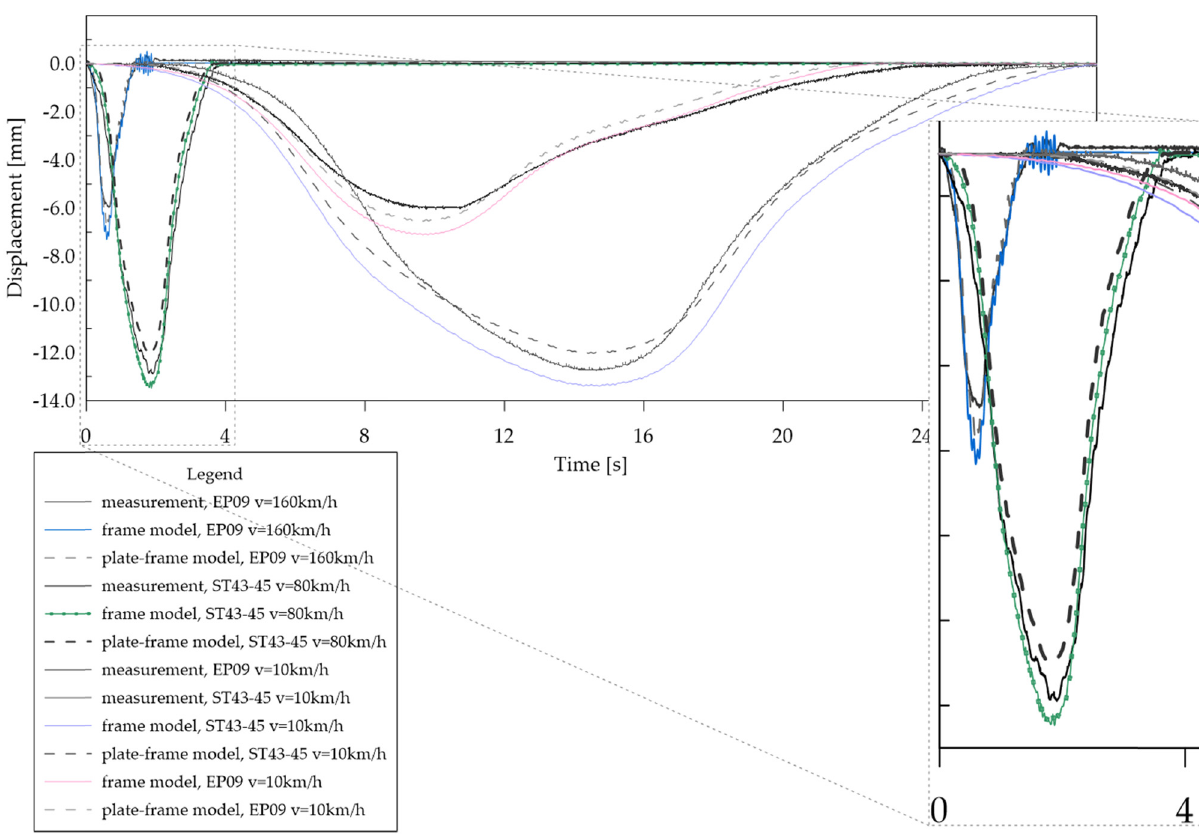
Figure 6: Comparison of the displacement values at 0.375 L t for selected combinations of dynamic locomotive transits.